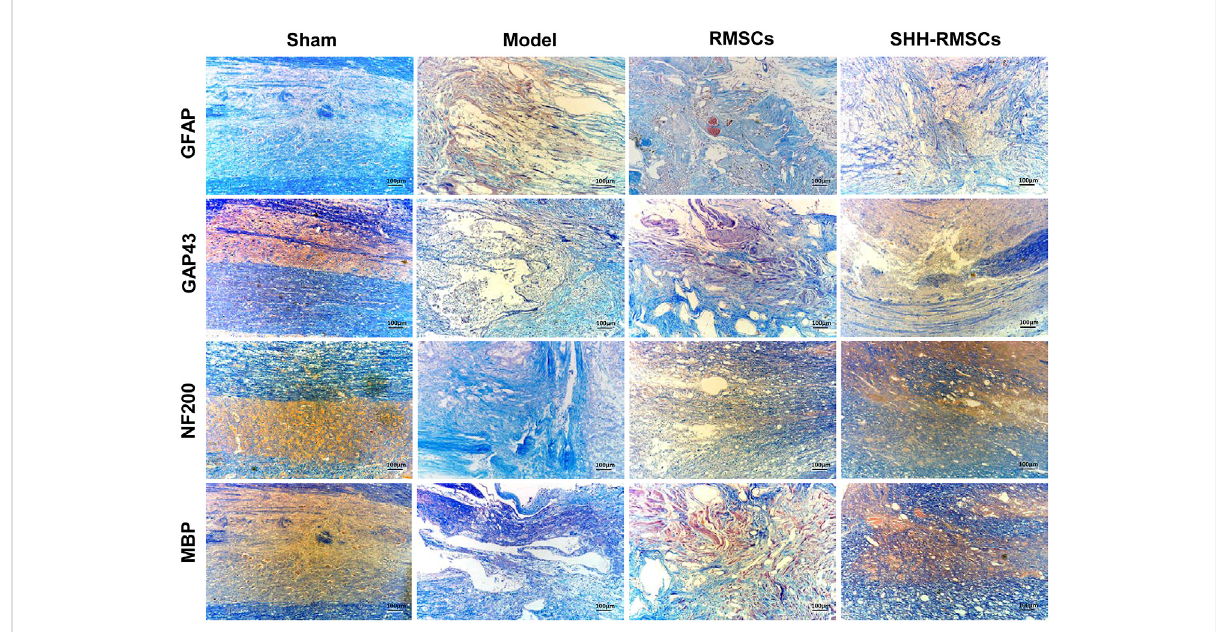
FIGURE 6 Immunohistochemistry of Sham, Model, RMSCs and SHH-RMSCs, including GAP43, NF200, MBP, and GFAP. SHH-RMSCs could signi fi cantly improve the expression of NF200, MBP, and GAP43, as well as inhibit GFAP